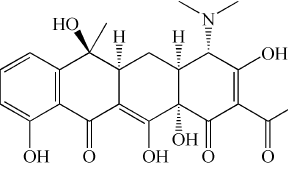
Figure 4. Chemical structure of tetracycline.